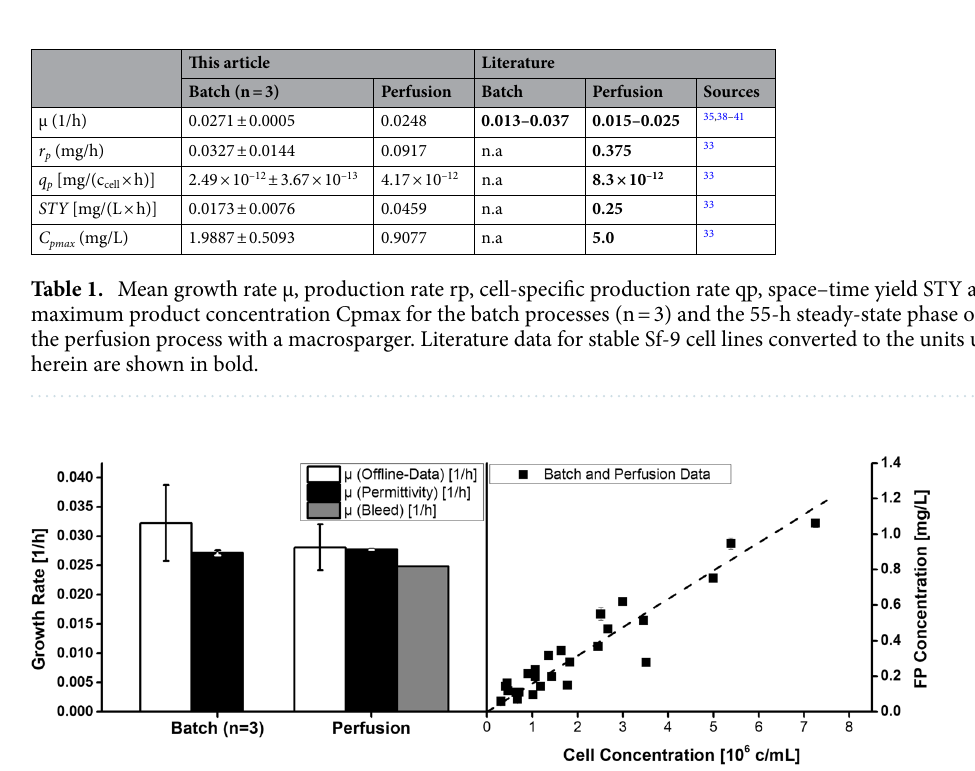
Figure 4. Perfusion process data from offline (left axes) and online (right axes) measurements. Acoustic separation and harvesting were started at t = 46 h. The turbidity setpoint was reached at t = 112 h, all process parameters were calculated from this point for the subsequent 55-h period.